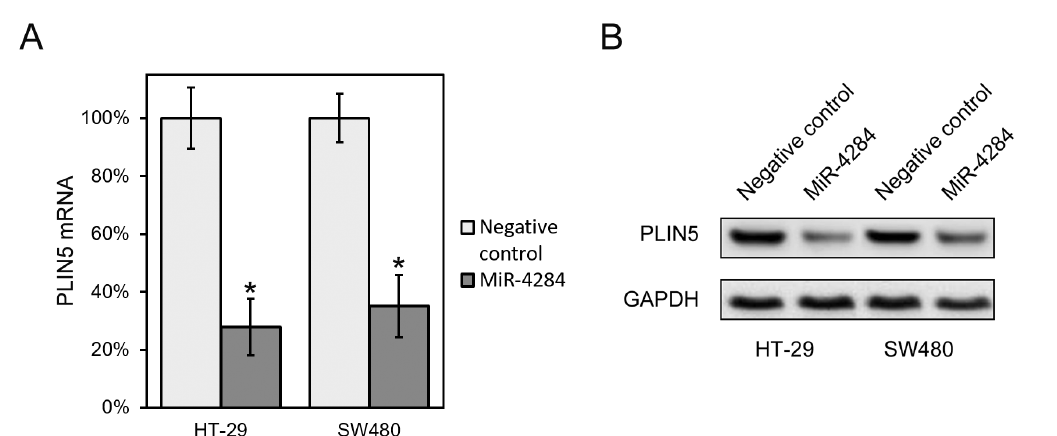
Figure 3. PLIN5 is down-regulated by miR-4284 expression in colon cancer cell lines. Levels of PLIN5 mRNA (A) and protein (B) in HT-29 and SW480 cells transfected with either miR-4284 or miRNA negative control. Values were mean ± SD of 3 independent biological replicates; * P < 0.05, compared to negative